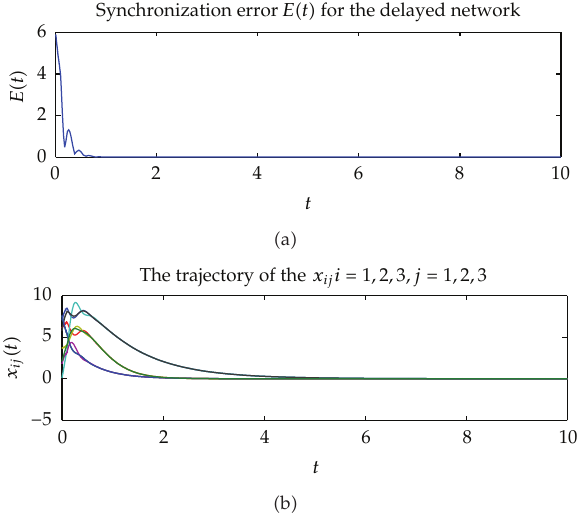
Figure 1: Synchronization evolution E (cid:3) t (cid:4) for the delay-independent network with c 1 (cid:8) 0 . 5, c 2 (cid:8) 1, and τ (cid:8) 0 .